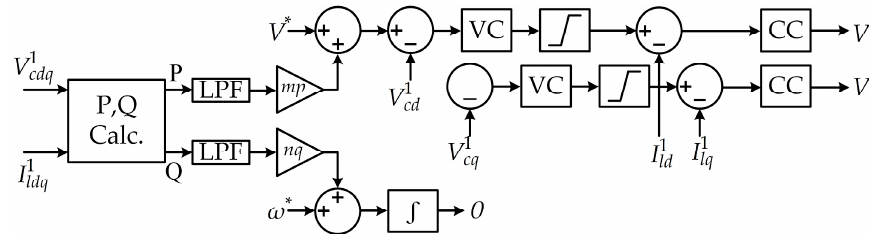
Figure 2. Inverse droop control utilized in the inverter. Model of the inverter in positive sequence is shown in Figure